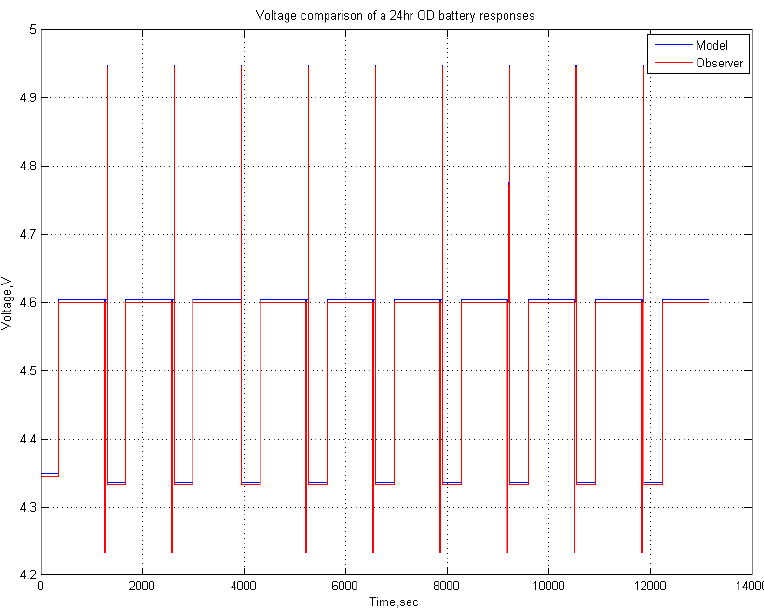
Figure 6. Model and observer response differences for 24-h OD battery operation.